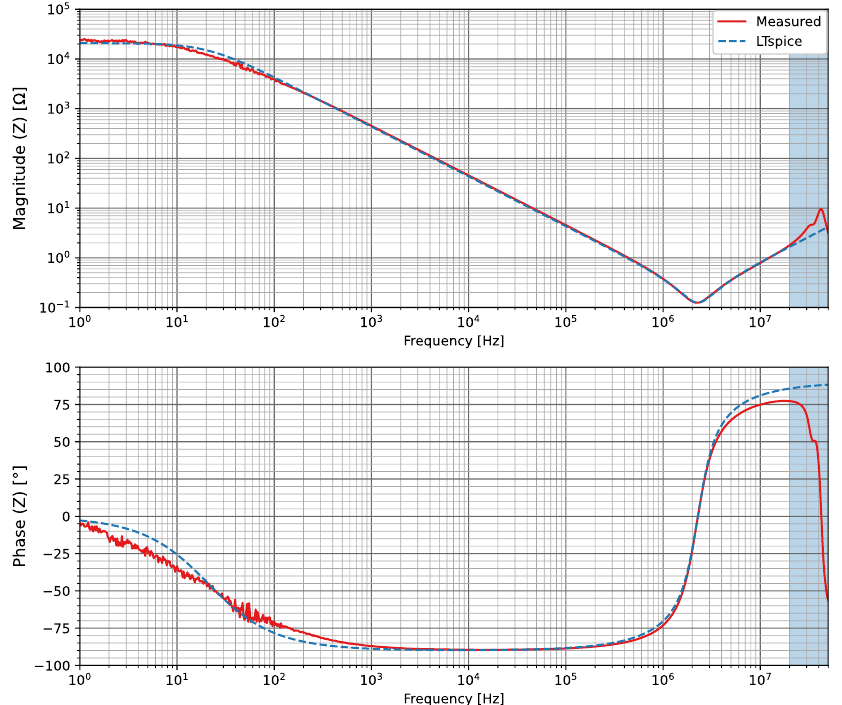
Figure 23. Small PV module measured (one-port) and simulated per-cell impedance curves (frequency range 1Hz to